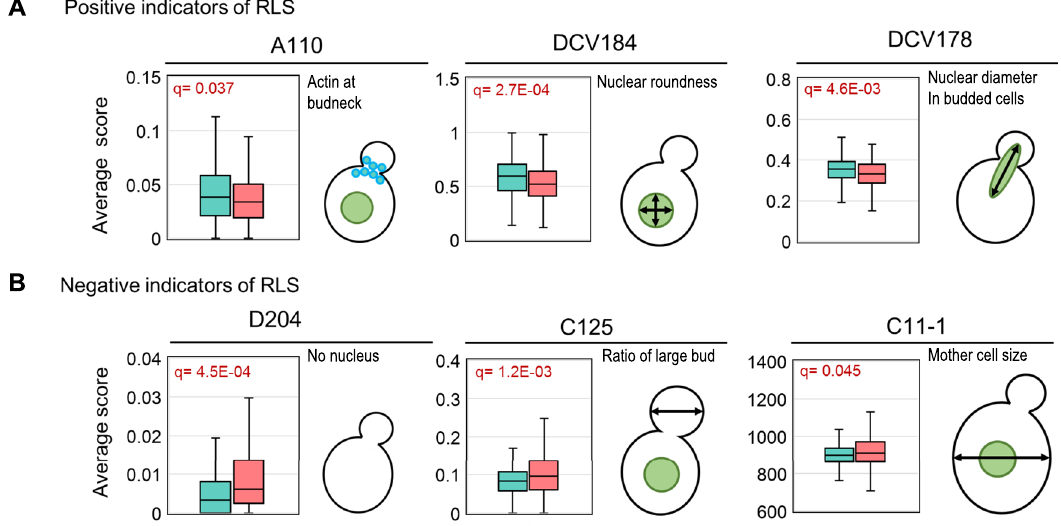
Fig. 2 Examples of age-related morphology changes. Positive ( A ) and negative ( B ) indicators of RLS are shown with distribution of average score of designated morphology traits, calculated from long-lived (green) and short-lived (red) groups. Box blots center represents median, whisker represents 1.5 inter quartile range, and lower and upper hinges represent fi rst and third quartiles, outliers were removed for